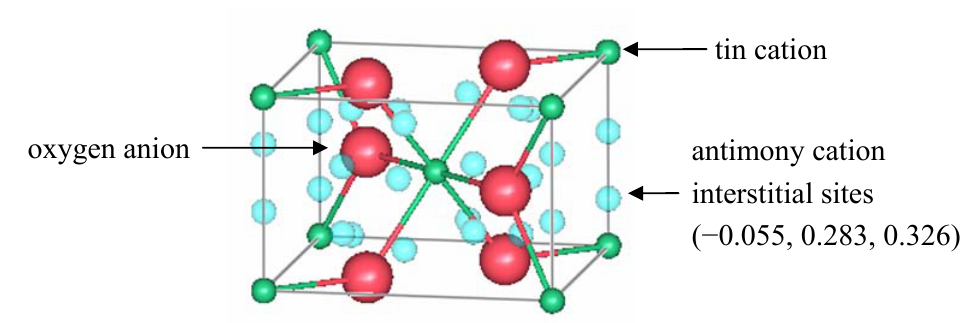
Figure 4. A unit cell of rutile SnO Berry and Greaves